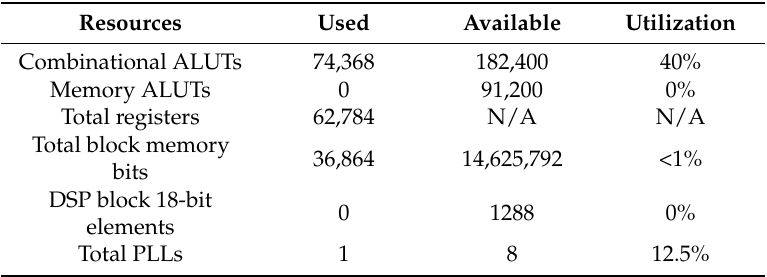
Table 1. Hardware resource usages of the proposed vector quantizer.